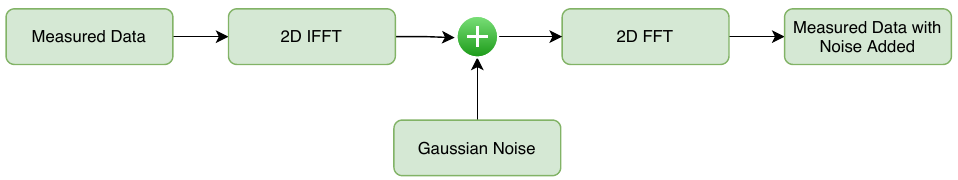
Figure 15. Addition of noise do the measured